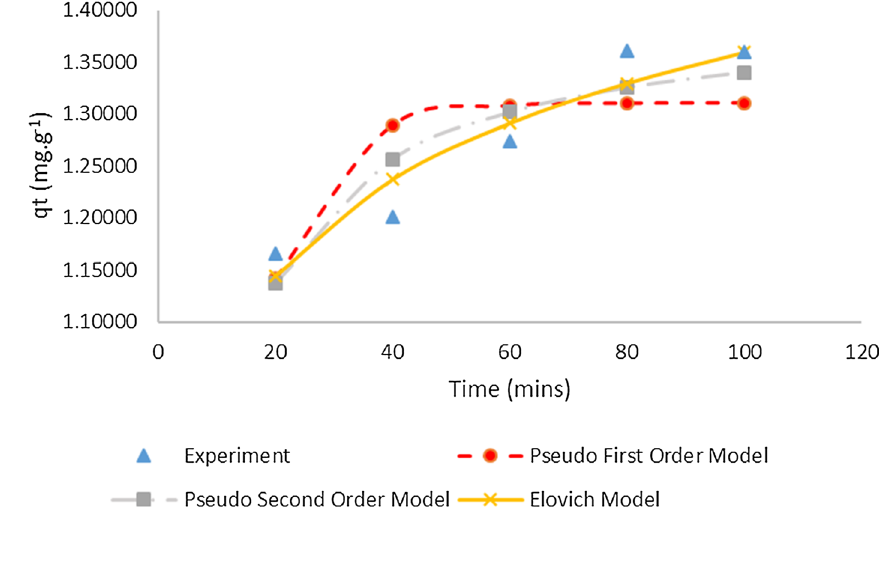
Table 4 Equilibrium Isotherm parameter constant and error functions of cyanide adsorption onto activated periwinkle shell carbon